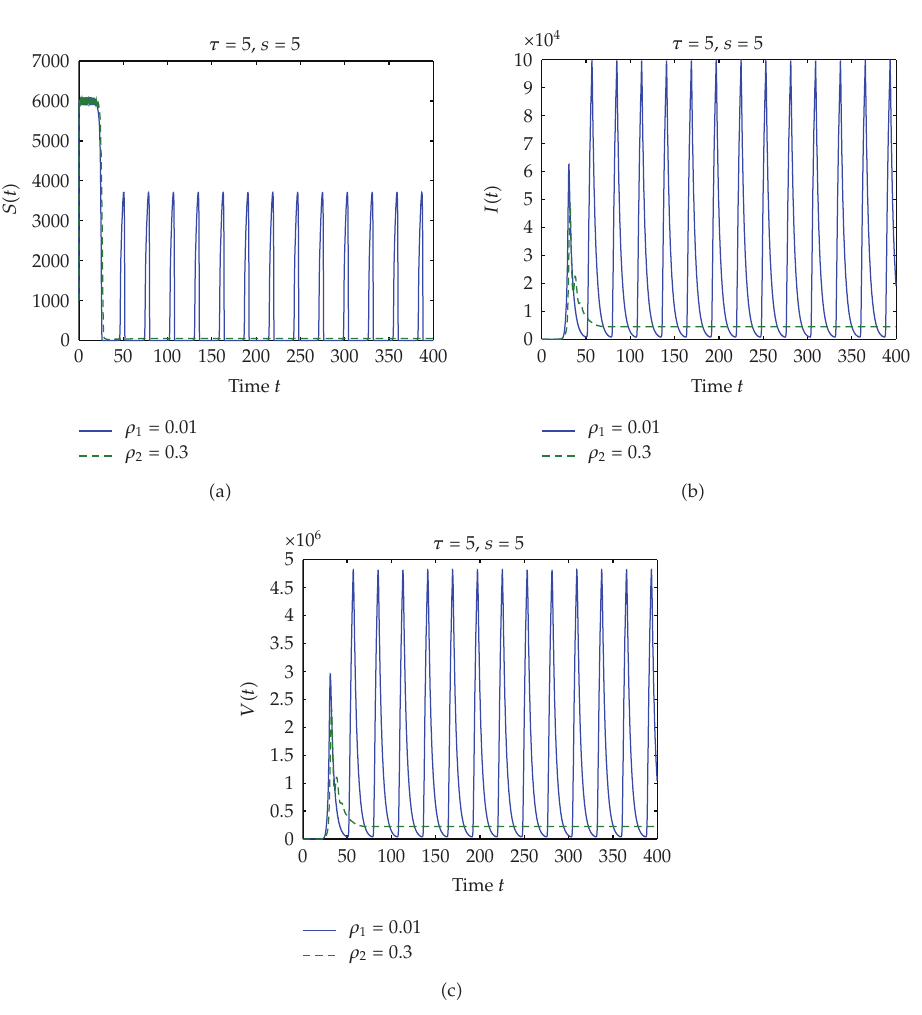
Figure 3: (cid:4) a (cid:5) – (cid:4) c (cid:5) show the uninfected cells, infected cells, and virus with ρ (cid:8) 0 . 01 and ρ (cid:8) 0 . 3 . They show that the cure rate is an important